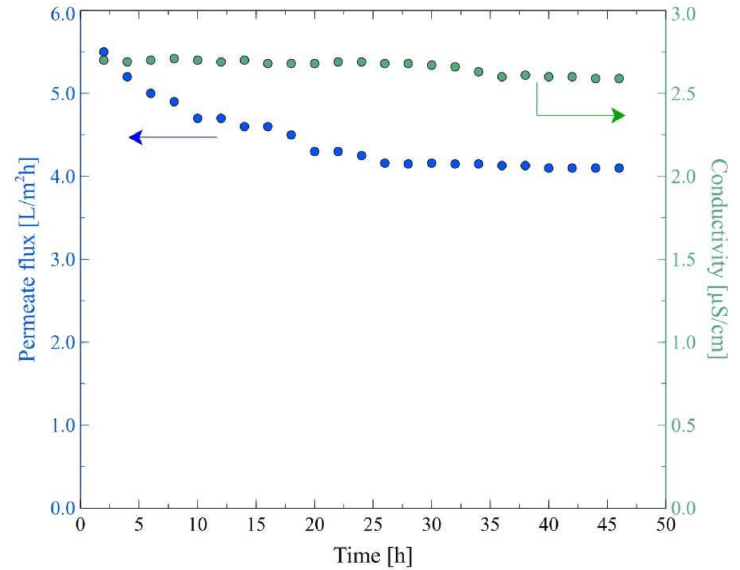
Figure 7. Changes in the permeate flux and distillate conductivity. Feed: NaCl solution (6 g/L), T F = 343 K, v F = 0.12 m/s. Module M2.